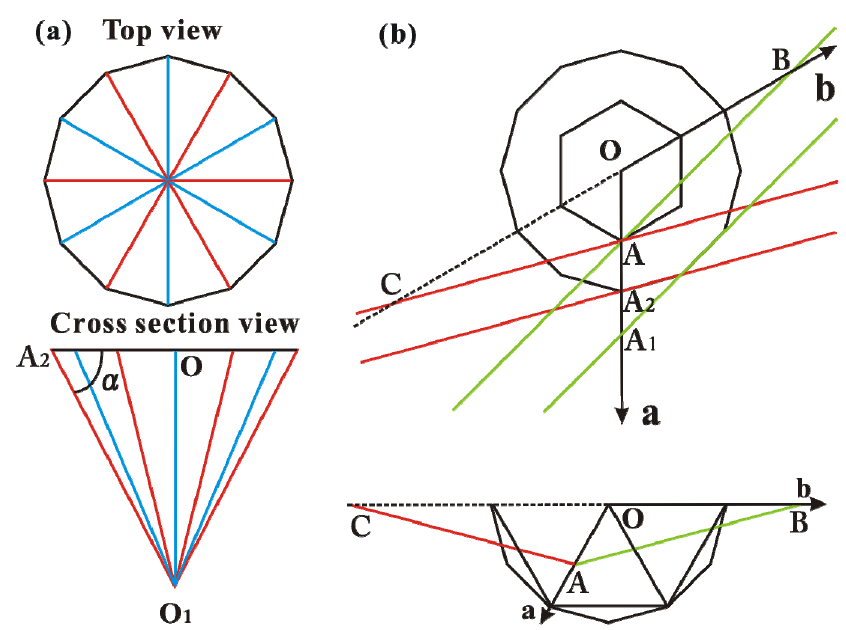
Figure 3. The schematic diagram of the dodecagonal pyramid with two different sets of ( a ) hexagonal facets and ( b ) the projection of the pyramid on (0001).